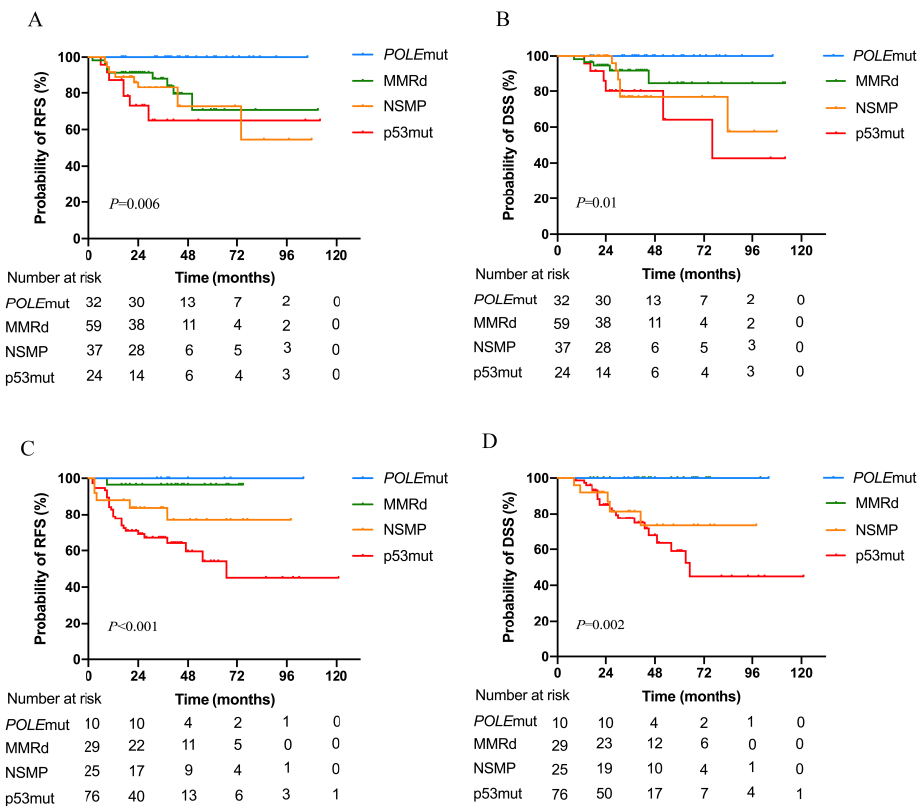
Figure 2. Kaplan-Meier curves showing the relapse-free survival (RFS) and disease-specific survival (DSS) of patients with high-grade endometrioid endometrial carcinoma (EEC) or non-EEC classified according to molecular subtype. ( A ) RFS in patients with EEC; ( B ) DSS in patients with EEC; ( C ) RFS in patients with non-EEC; and ( D ) DSS in patients with non-EEC. NSMP, non-specific molecular profile; p53mut, P53 mutation; POLE mut, polymerase epsilon mutation; UEC/DEC, undifferentiated/dedifferentiated endometrial carcinoma. Table 2. Univariate analysis of factors potentially predictive of survival in patients with high-grade endometrial cancer.